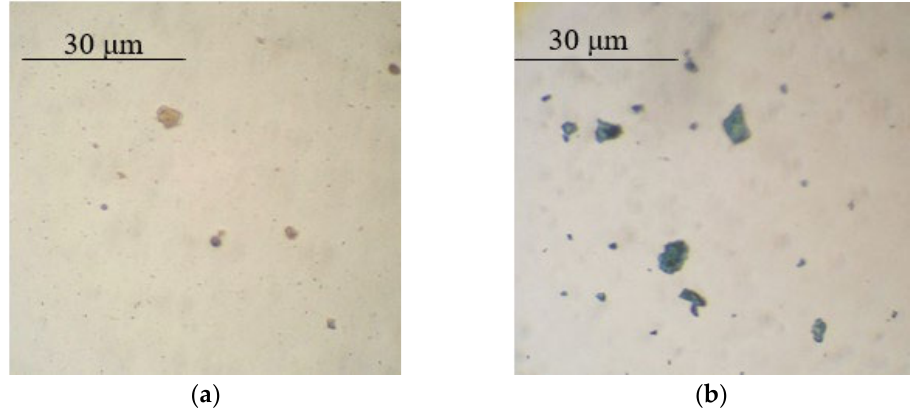
Figure 3. Micrographs of mica ( a ) and core/shell pigment with a mica core ( b ) (20 wt.% of PANi, sulfuric acid used as a dopant).